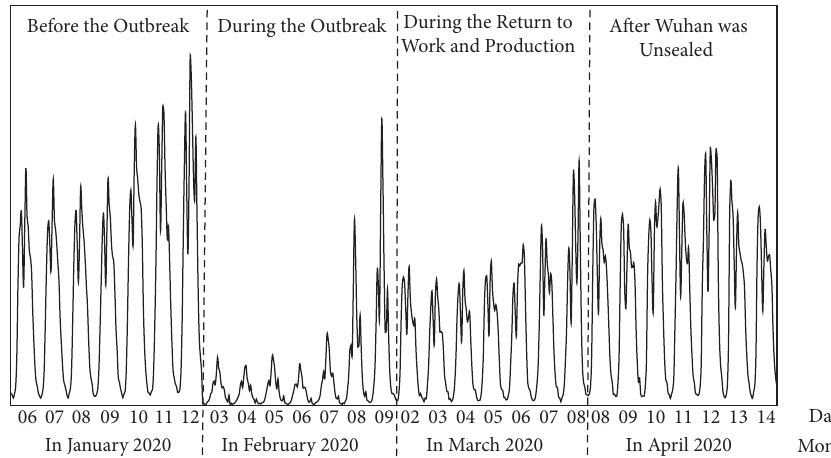
Figure 4: Intercity highway OD flows between Changsha and Yueyang in four different time periods.